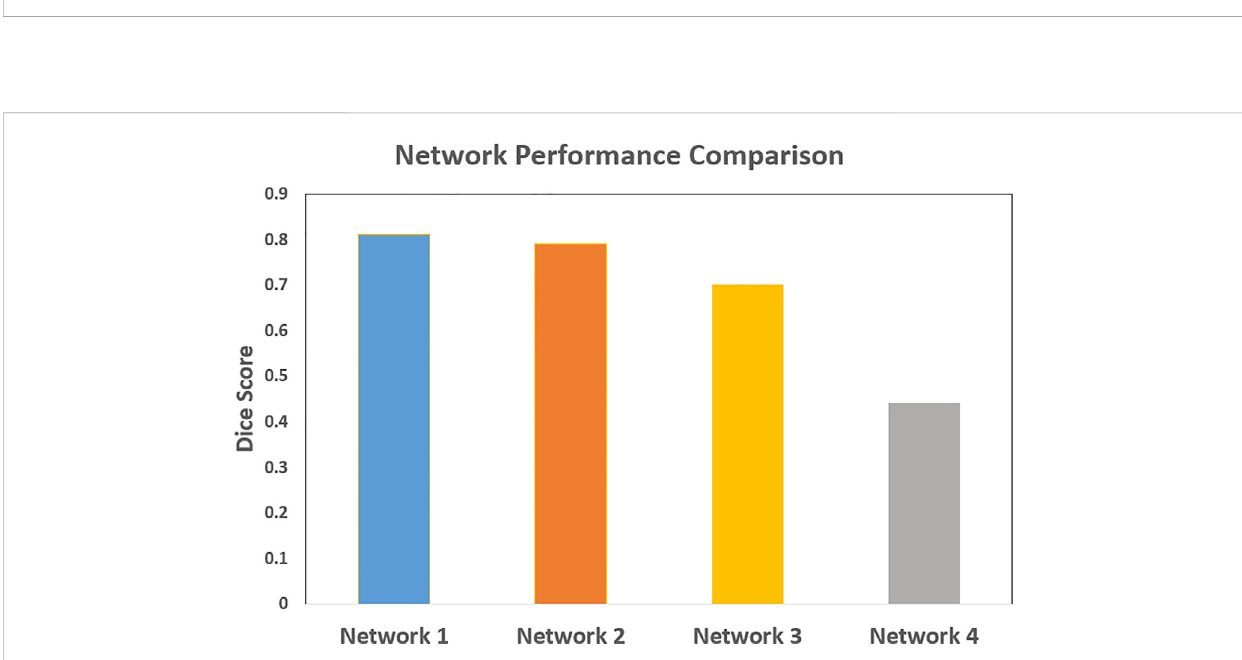
FIGURE 11 The comparison of the neural network performance for four different network architectures by means of Dice score. Network 1: 5 levels of convolution with 32, 64, 128, 256, and 512 features; Network 2: 5 levels of convolution with 16, 32, 64, 128, and 256 features; Network 3: 4 levels of convolution with 32, 64, 128, and 256 features; and Network 4: 4 levels of convolution with 16, 32, 64, and 128 features. The network performed better with 5 levels of convolution, and a higher number of